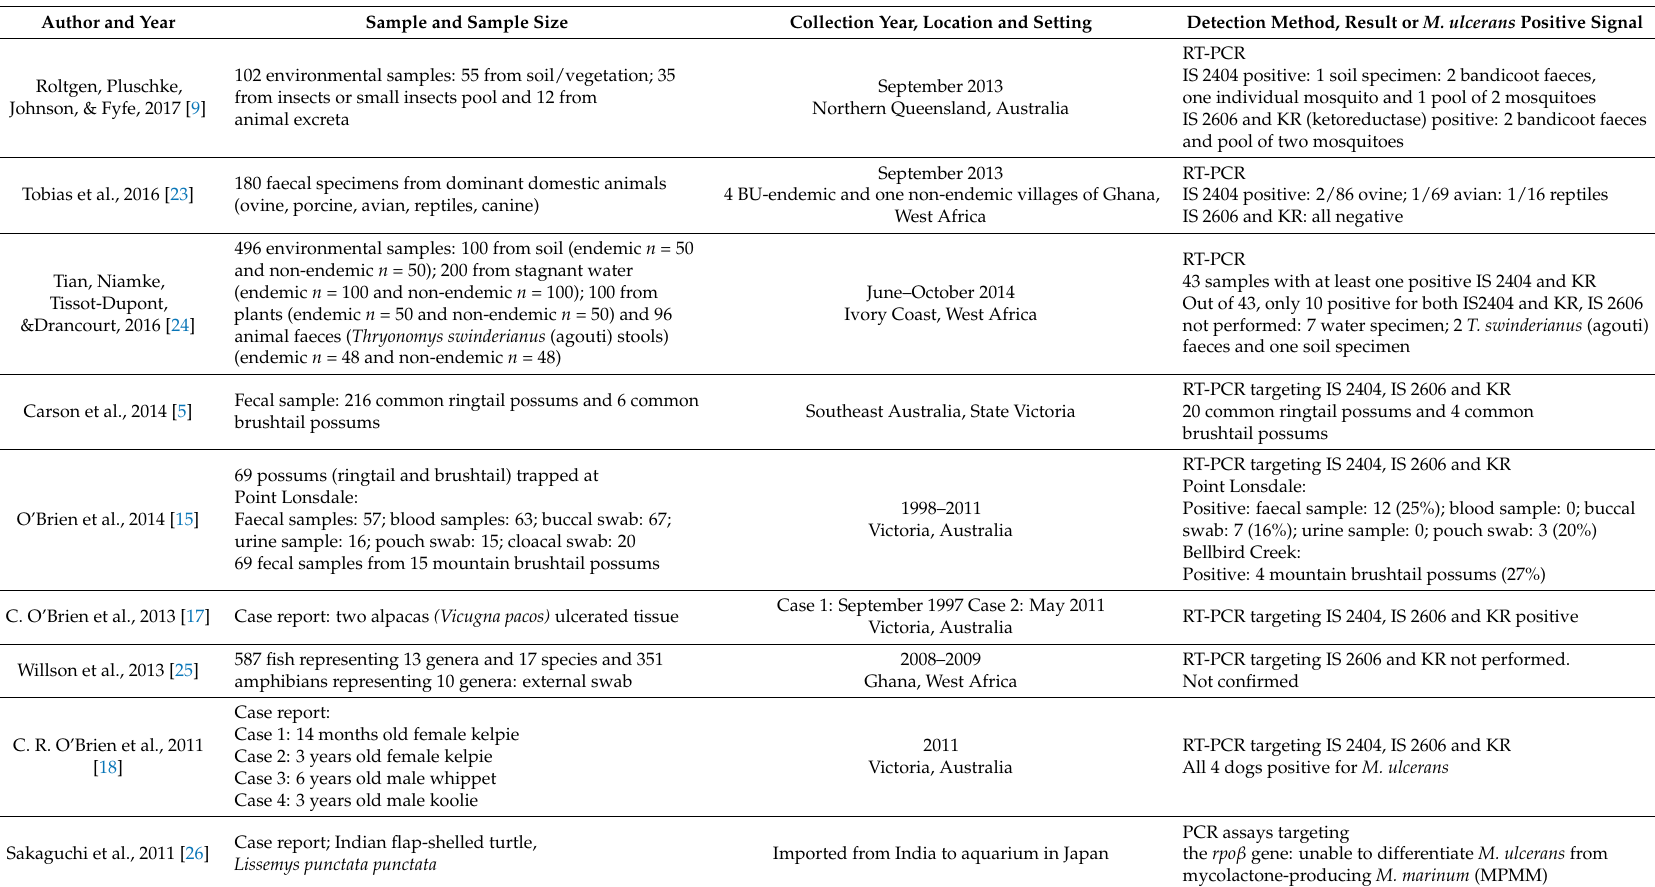
Table 1. Basic characteristics of selected studies on occurrence of Mycobacterium ulcerans